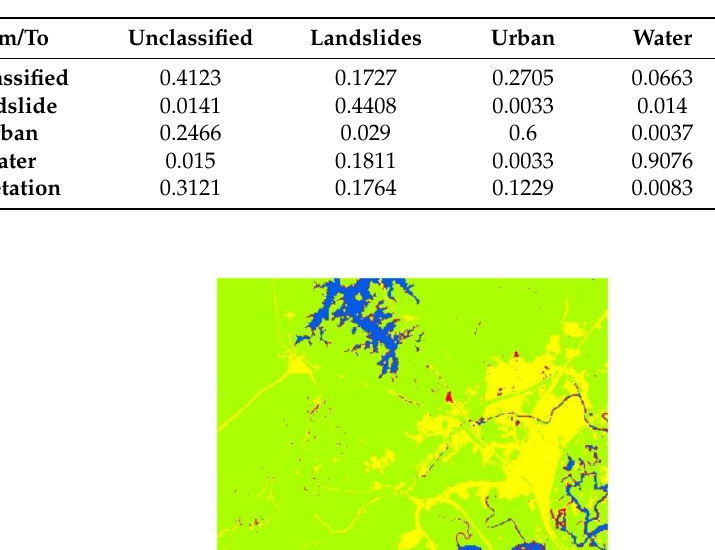
Figure 9. Evolution of the probability of correct classification for the classifier ensembles.